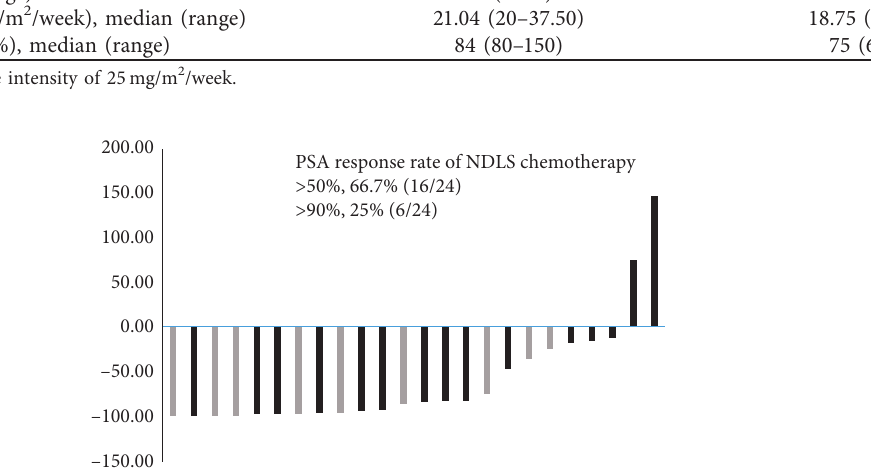
Figure 1: PSA response rate of NDLS chemotherapy. Bar charts show PSA response rate for each patient who received NDLS chemotherapy. Bars in black color indicate the 3-weekly group, and bars in grey color indicate the 2-weekly group. Table 3: Efficacy